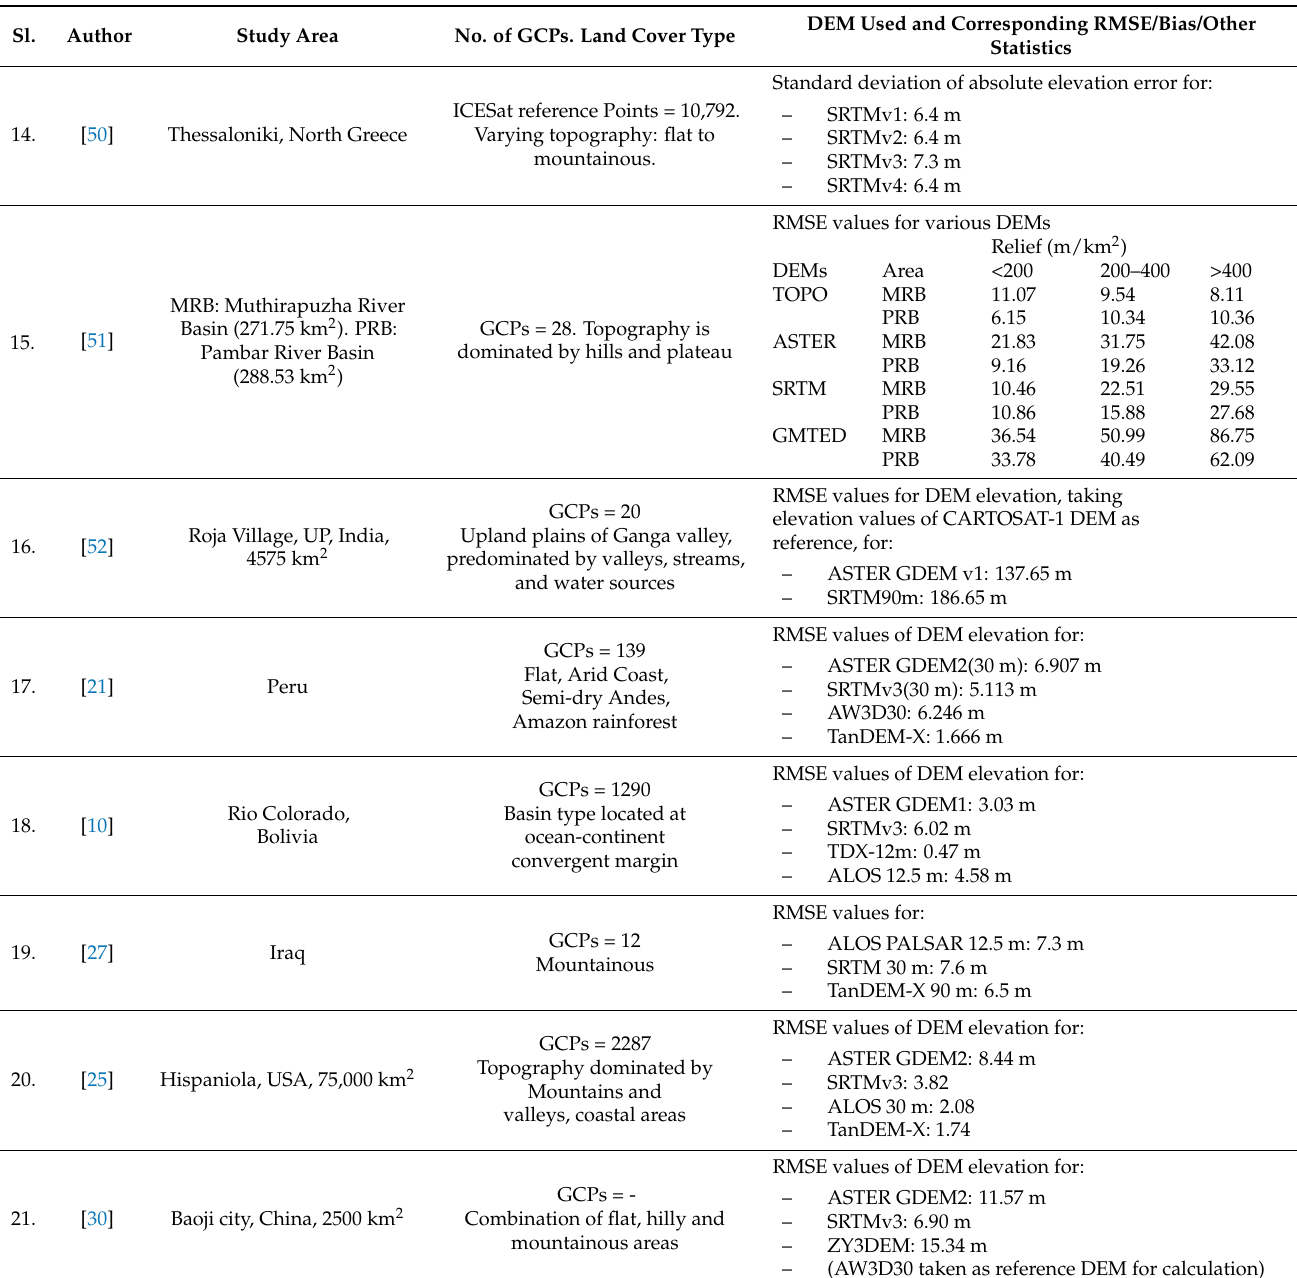
parative performance of ground-based equipment: DGPS and android-based MobileGPS; (2) vertical accuracy assessment of public domain DEMs: ASTER GDEM v3, SRTM v3, SRTM v4.1, CartoDEM v3R1, MERIT, and TanDEM-X DEM over the IIT(ISM) campus and the surrounding area; (3) enhancement of vertical accuracy of DEMs, corrected using linear fit, and removal of systematic error; (4) comparison of corrected and uncorrected DEMs through statistical analysis and tests; (5) comparison of three commonly used interpolation methods; nearest neighbour (nn), bilinear (bl) and bicubic (bc) in DEM resampling; and (6) to find the optimum number of GCPs with minimum